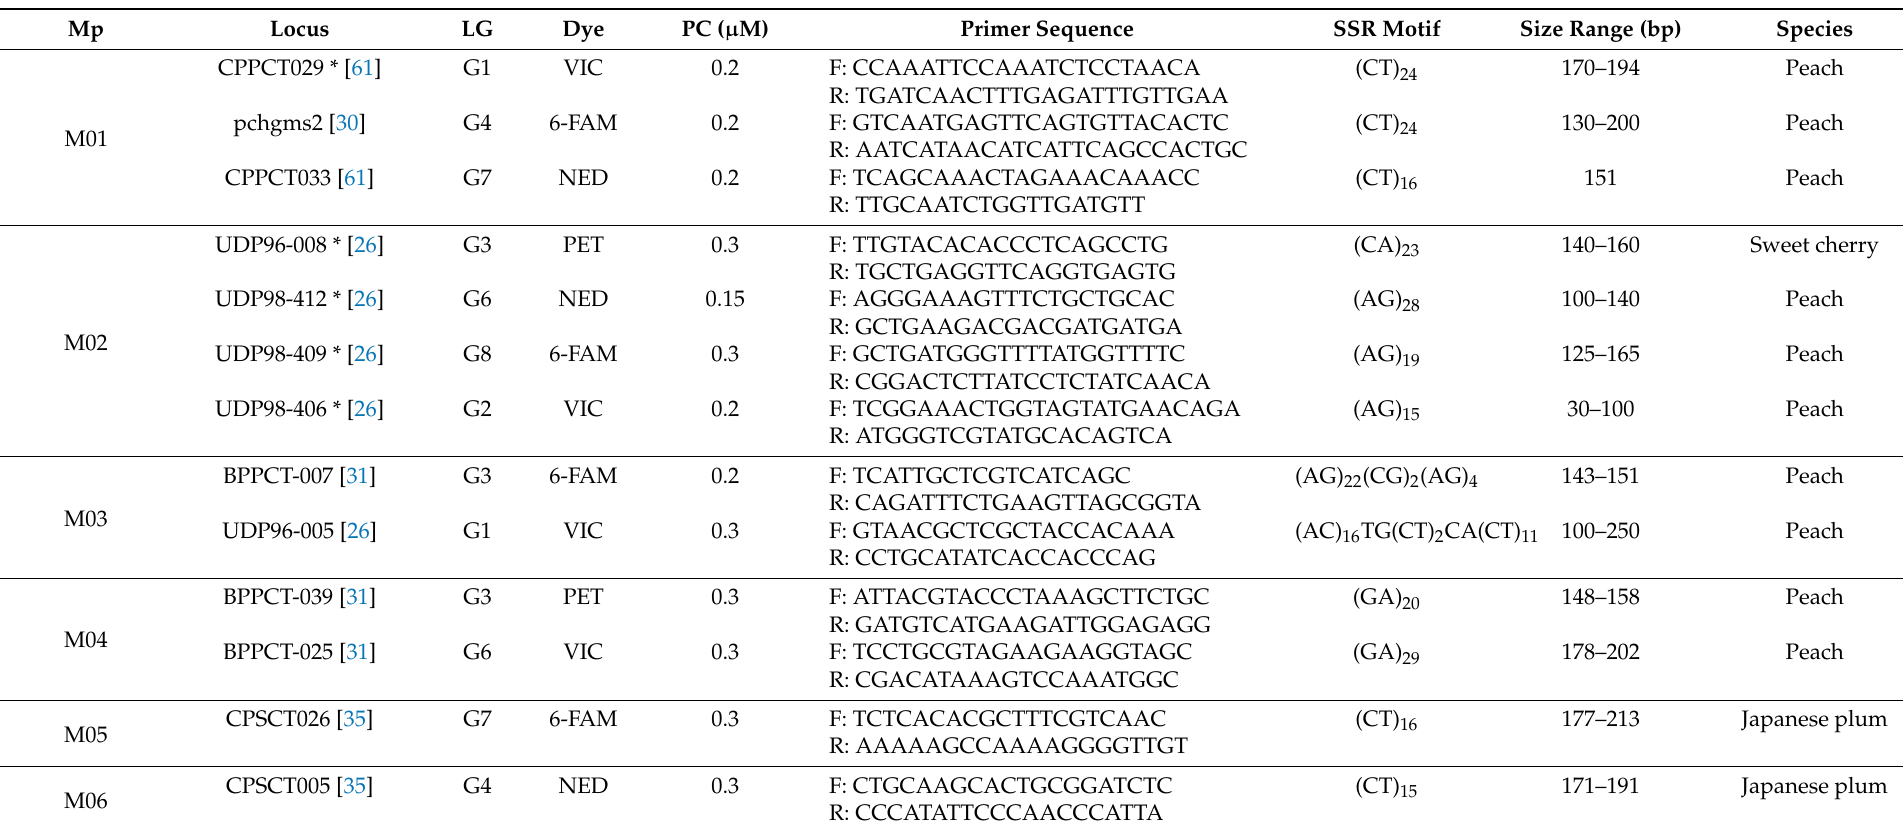
Table 2. Multiplex (Mp) design, SSR loci, linkage group (LG), fluorescent dyes, primer concentration (PC), PCR details, and characteristics of the 13 SSR markers analyzed in this